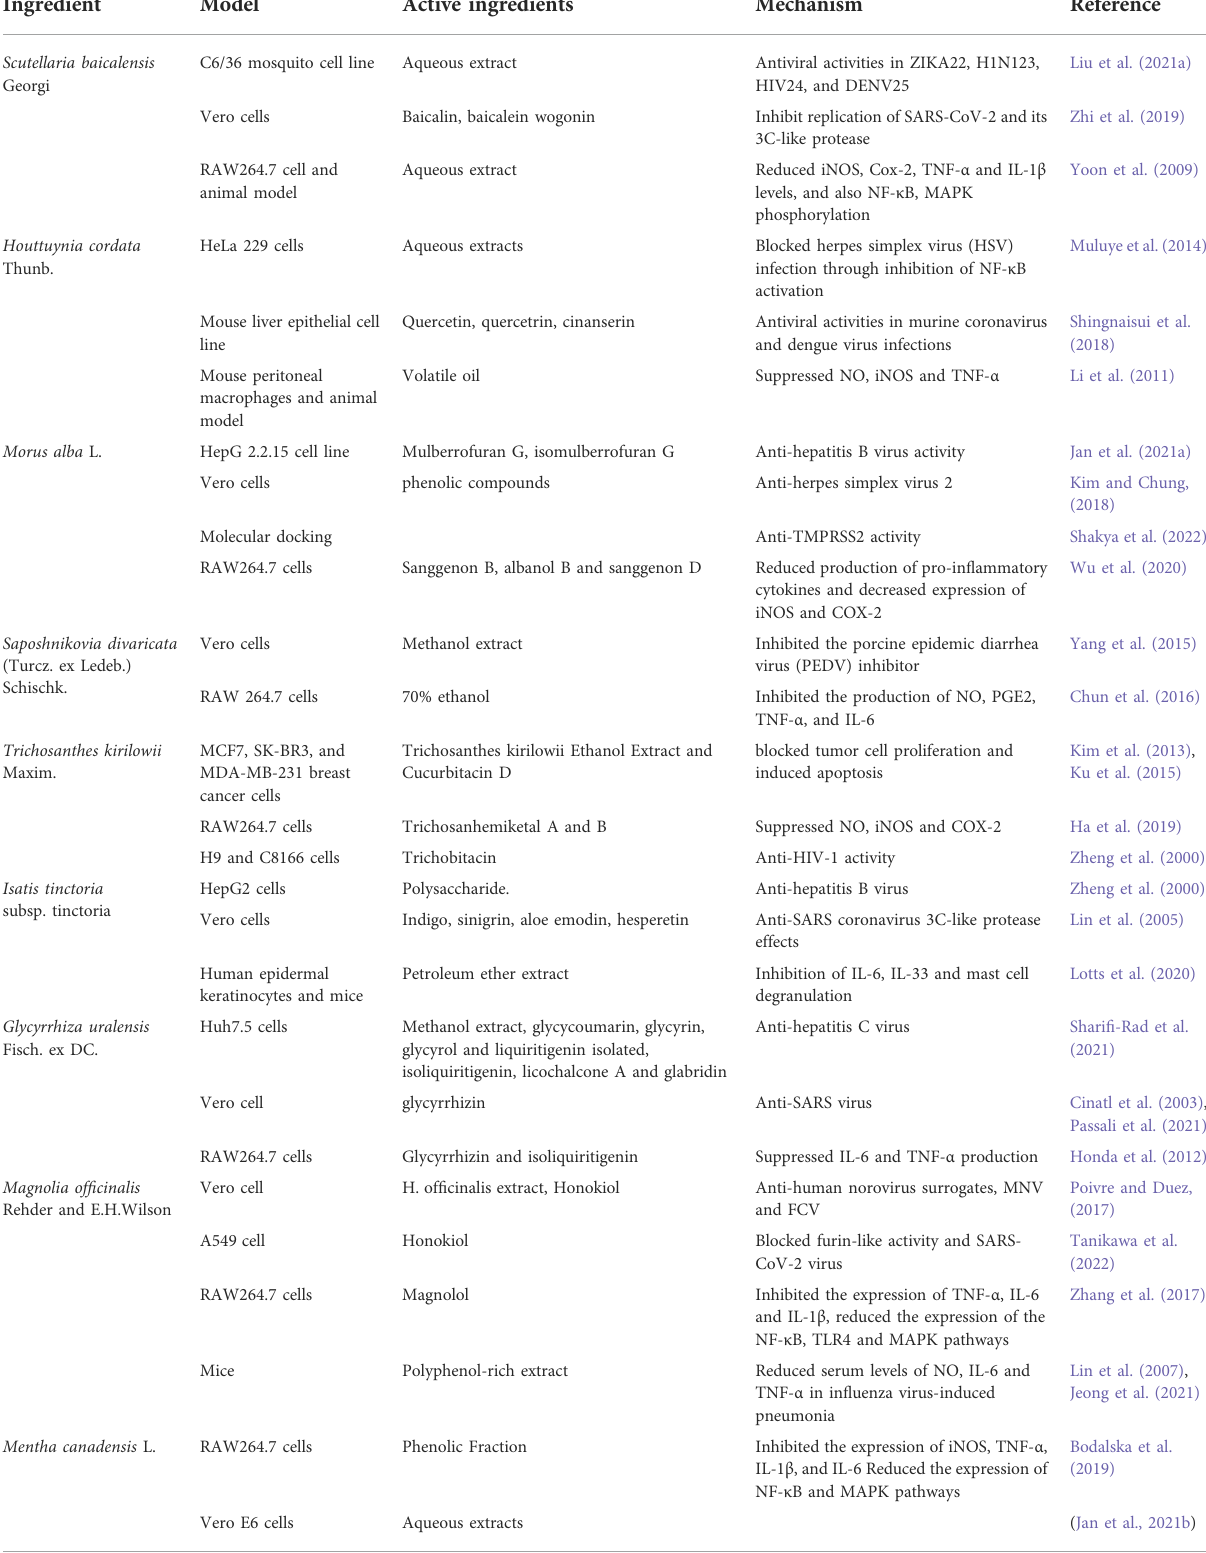
TABLE 3 The potential ef fi cacy of the herbs of Taiwan Chingguan Yihau (NRICM101) used as adjunctive therapies in COVID-19 infection.